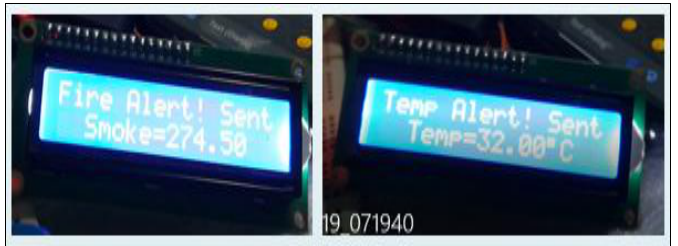
Figure 11: Alert messages on the LCD when MQ5 detected fire and DHT11 detect temperature increase.